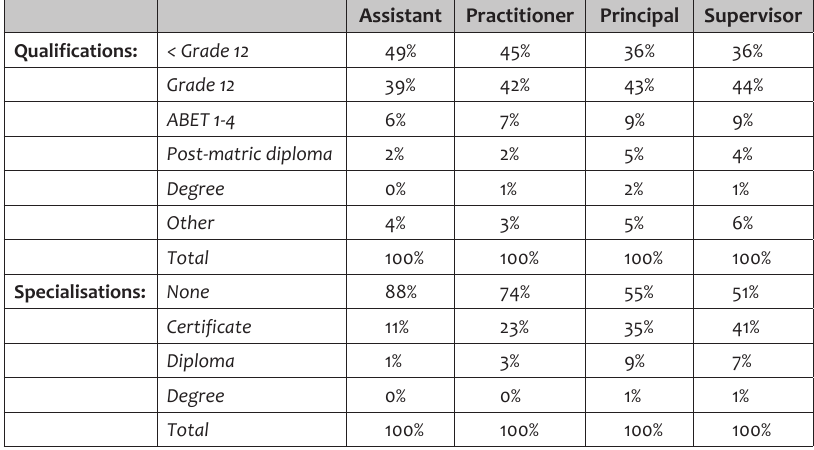
Table 3: ECD practitioner qualifications and specialisations, 2013 (Source: RSA DSD